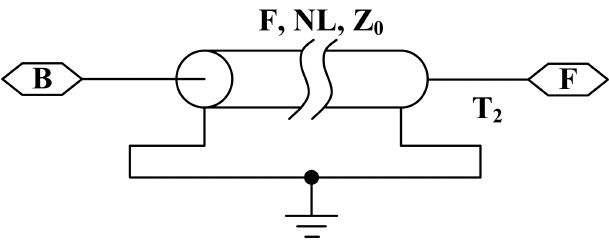
Figure 5. The lossless transmission line model in PSpice.